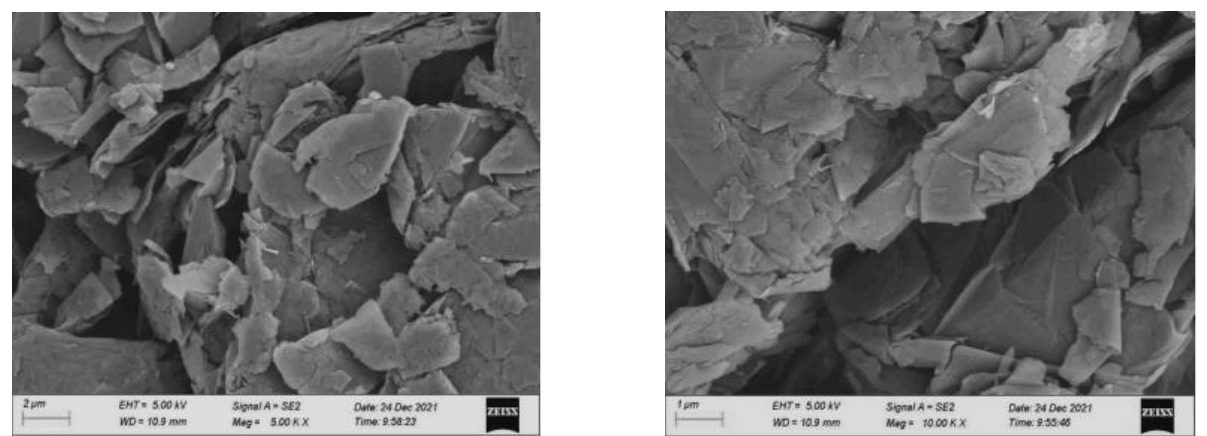
Figure 1. Graphene. Figure 1. Graphene.